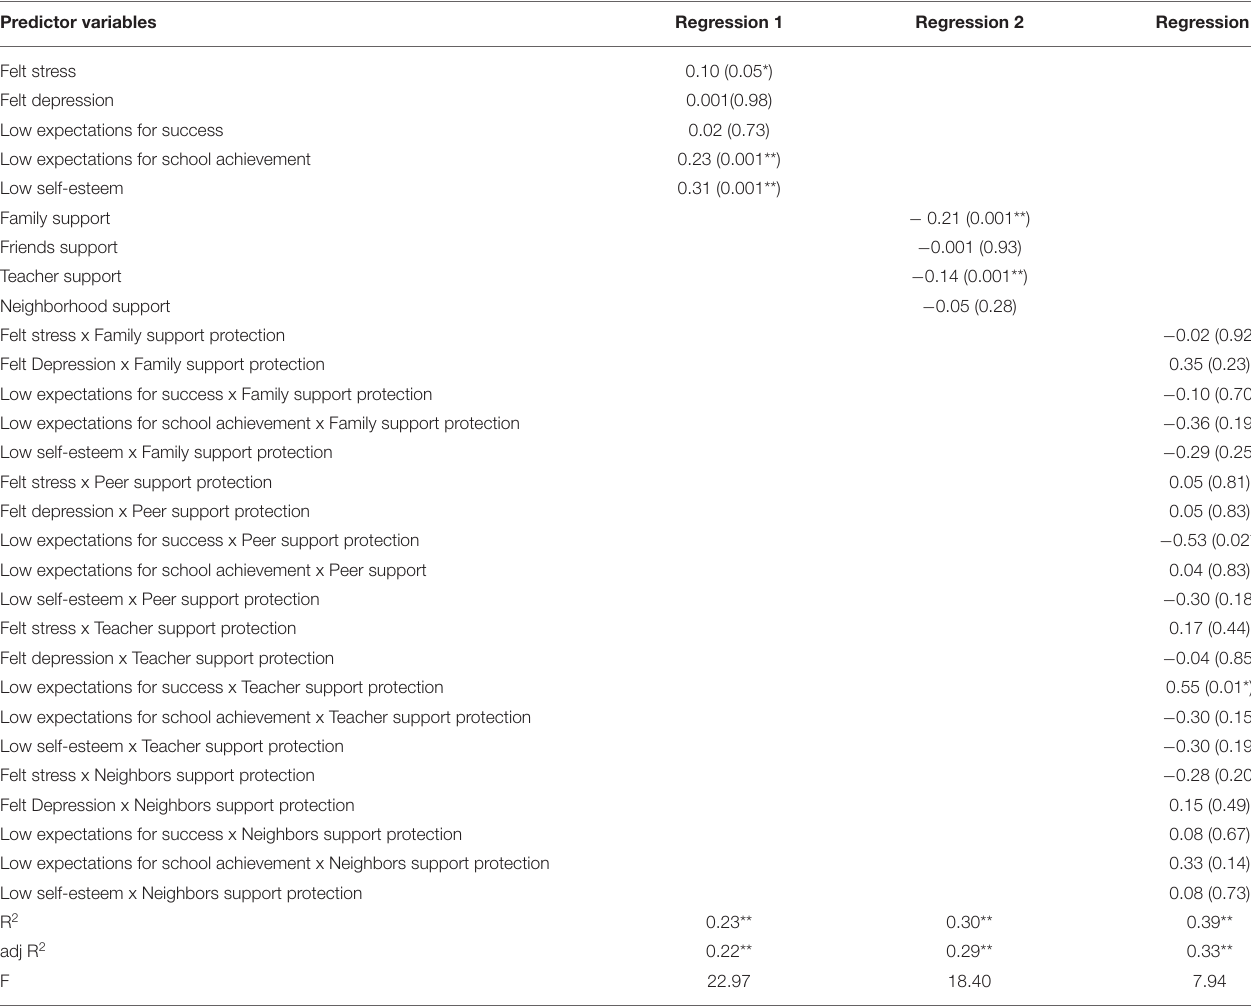
TABLE 2 | Results of hierarchical multiple linear regression analyses for individual vulnerability and support and interaction between these variables in their effects on delinquent behaviors ( n = 392). Predictor